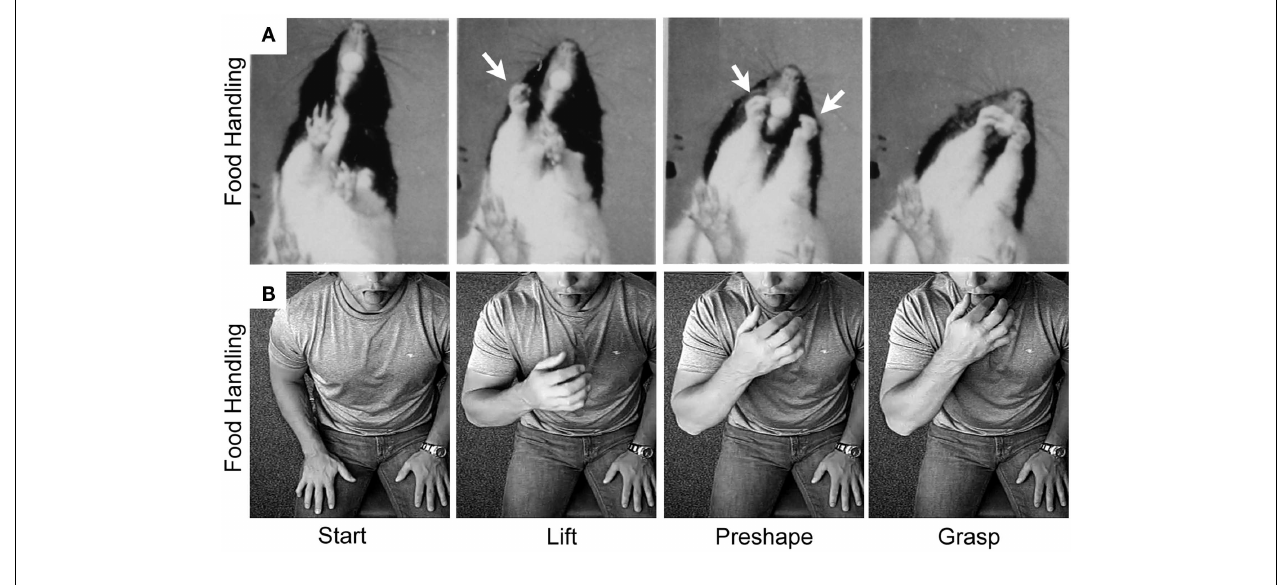
the digits then preshape to the target, and finally the digits close on approach to the target in order to grasp it.White arrows indicate hand preshaping in the rat. Adapted fromWhishaw et al. (97) and Karl et al. (38, 40).